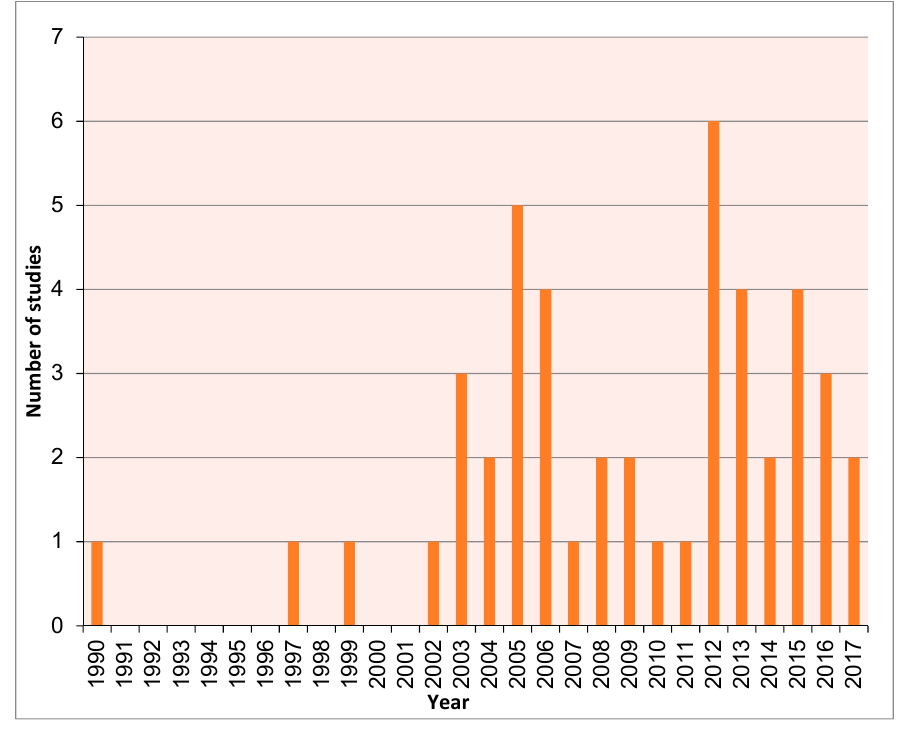
Figure 1. Number of ancient DNA (aDNA) studies including micromammals from 1990–2017.